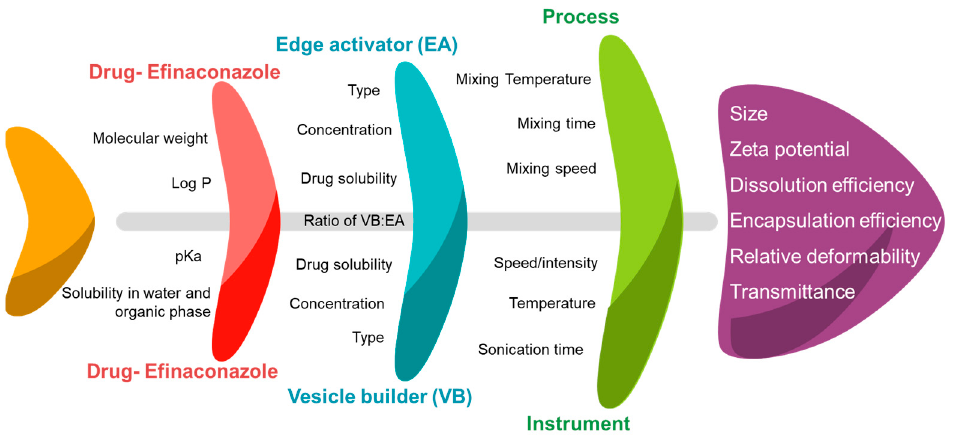
Figure 1. An Ishikawa fishbone diagram displaying the cause-effect relationship of several inde- pendent CFAs and CPPs that can affect the critical quality parameters of efinaconazole